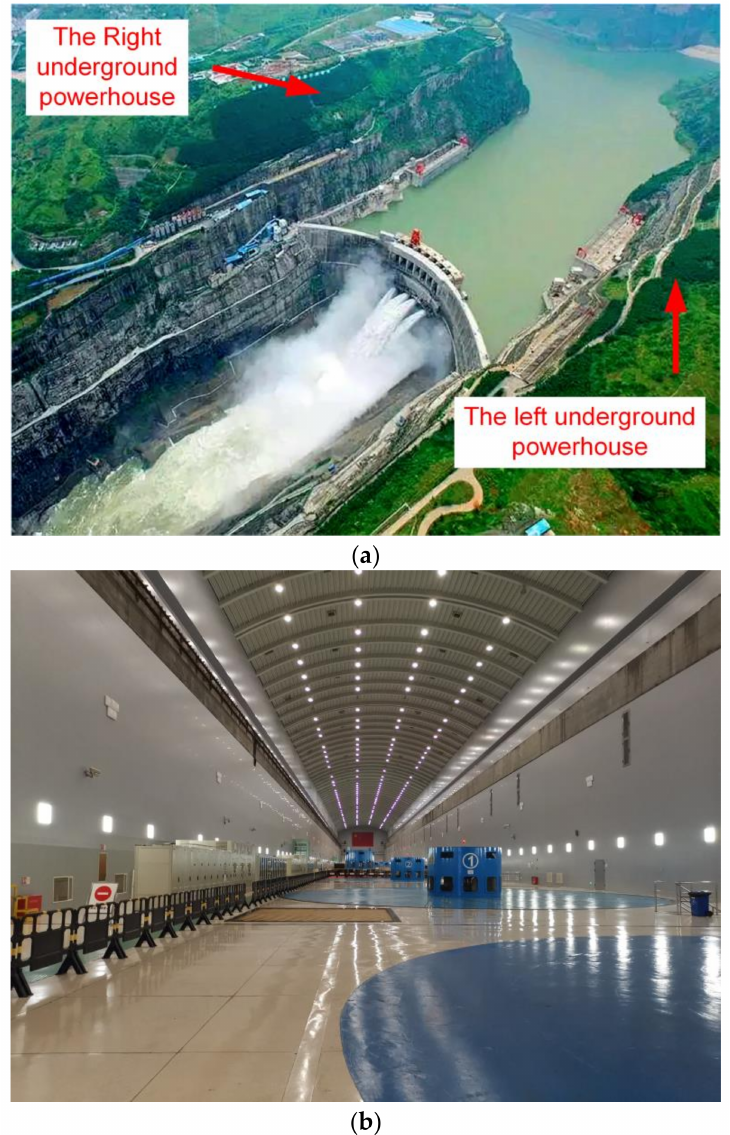
Figure 3. The Xiluodu HPP: ( a ) the arch dam; ( b ) the underground hydropower